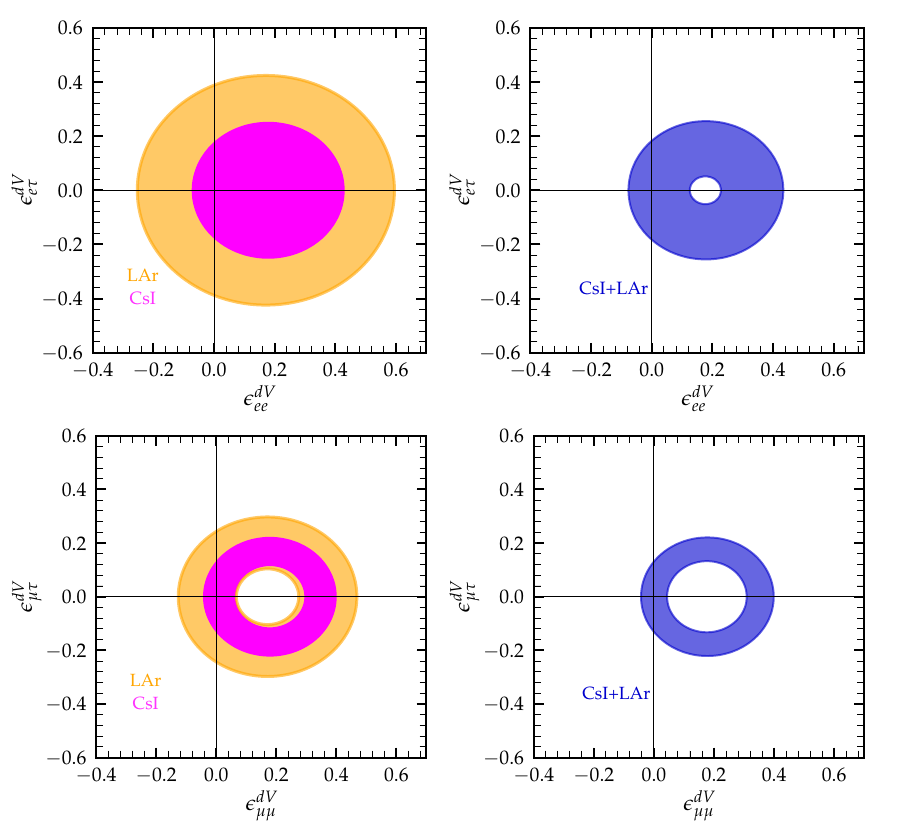
Figure 5 . 90% C.L. (2 d.o.f.) allowed regions assuming one nonuniversal and one flavor-changing neutrino NSI, extracted from the analysis of CsI (magenta), LAr (orange) and the combined CsI + LAr (blue) data. The upper panel shows the result in the ( (cid:15) dV panel shows the corresponding result in ( (cid:15) dV